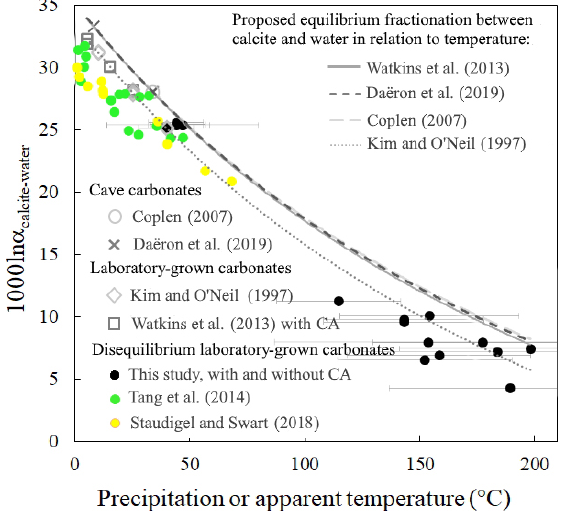
Figure 7. The relation to temperature of the equilibrium oxygen isotope fractionation factor between calcium carbonate and water (1000ln α calcite − water ) appears to be retrievable from solid carbon- ates (mainly calcites) in strong clumped and oxygen isotope dis- equilibrium such as our microbial carbonates (black dots, precipi- tated at 30 ◦ C) and two additional data series of laboratory-grown carbonates showing disequilibrium fractionation (Tang et al., 2014; Staudigel and Swart, 2018) (green and yellow dots, respectively). The data points affected by CO 2 hydroxylation (Tang et al., 2014) or CO 2 degassing (Staudigel and Swart, 2018) (see Fig. 6) are not included. Grey symbols correspond to cave carbonates precipitated at or near equilibrium (Coplen, 2007; Daëron et al., 2019) or lab- oratory experiments (Kim and O’Neil, 1997; Watkins et al., 2013). Those grey data series are usually considered representative of the equilibrium fractionation factor between calcium carbonate and wa- ter whose relations to temperature, extrapolated at high temperature, are illustrated by the different dashed curves. Plotted temperatures correspond to precipitation temperatures except for disequilibrium carbonates for which apparent temperatures have been calculated based on (cid:49) 47 values. The x -axis errors for this study are included in the symbol size. The y -axis error for all the reconstructed tem- peratures is given on the